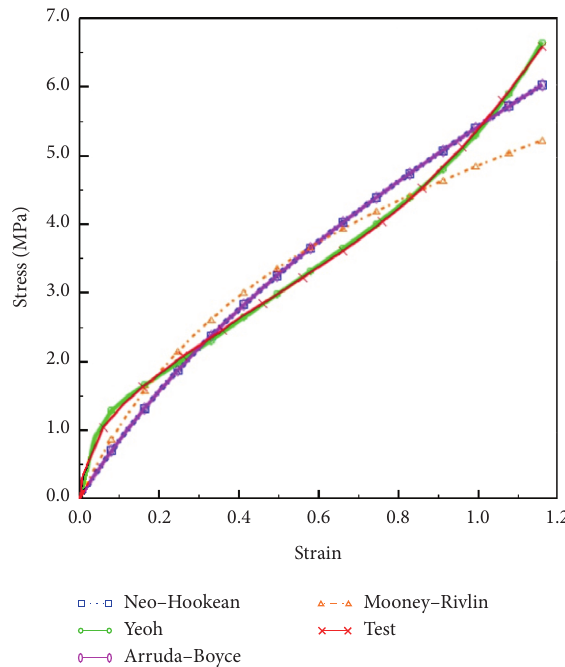
Figure 4: Fitting curves of hyperelastic models in the uniaxial tensile